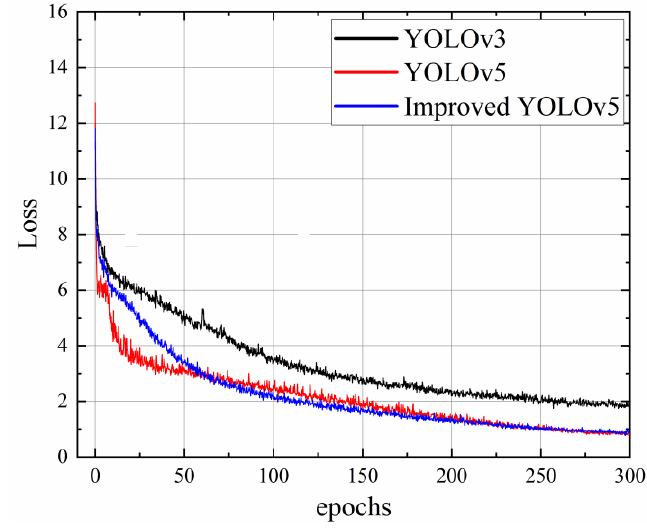
Figure 9. Comparison of loss functions of YOLOv3, YOLOv5s, and improved YOLOv5s models.